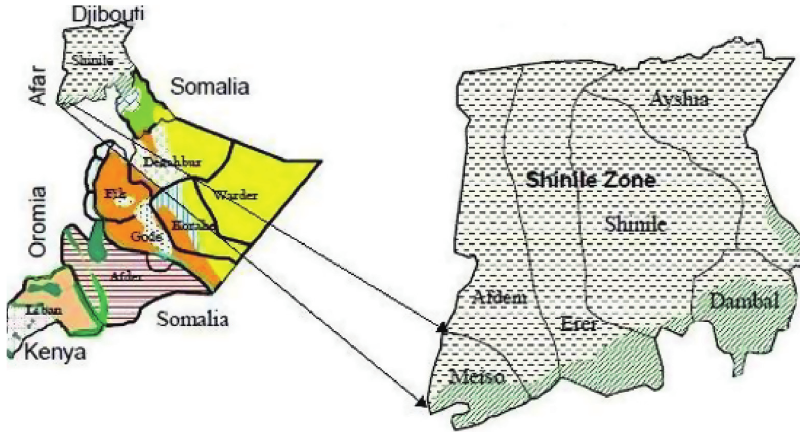
Figure 1: Maps of the study area (source: Save the Children,